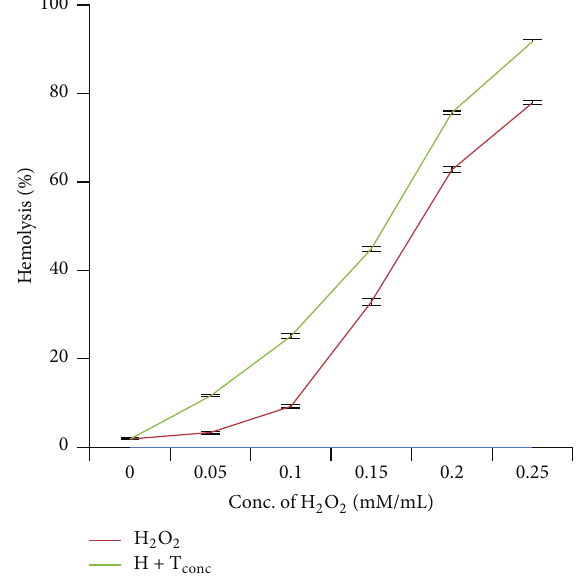
Figure 1: Effect of hydrogen peroxide and its combination with bisphenol A on red blood corpuscles. Results are expressed as mean ± SEM; 𝑛 = 10 . ∗ Significant at the level 𝑃 < 0.05 as compared to